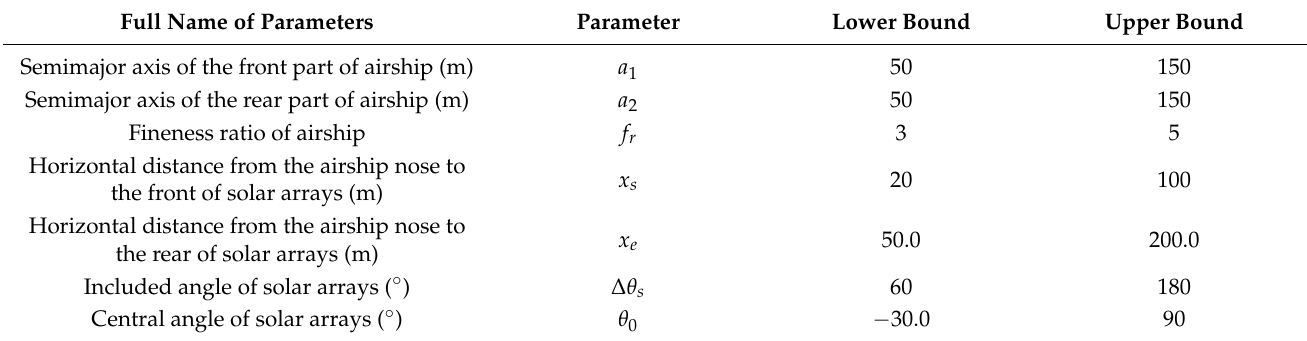
Table 1. Design variables and design